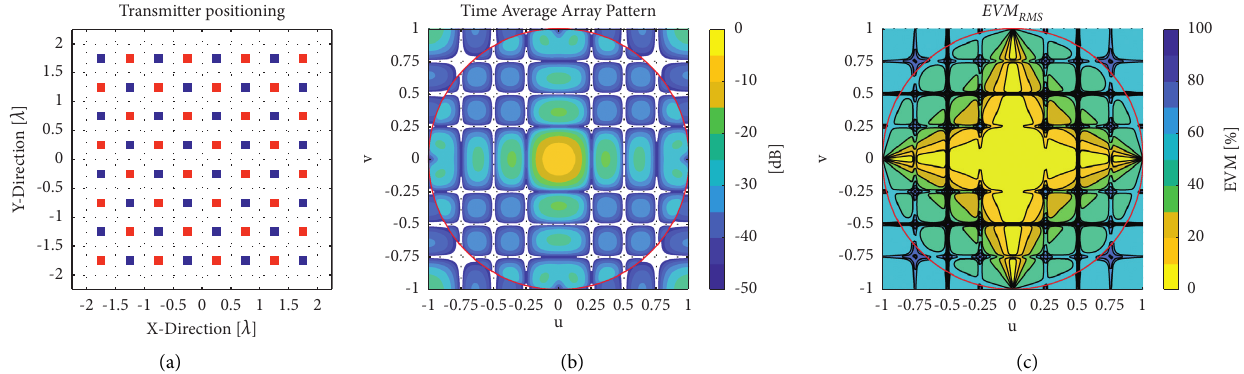
Figure 4: Nonsymmetric outspacing array performance: K � L � 8, d cos θ element pattern is used. (a) Array configuration. (b) Time average array pattern. (c) EVM.